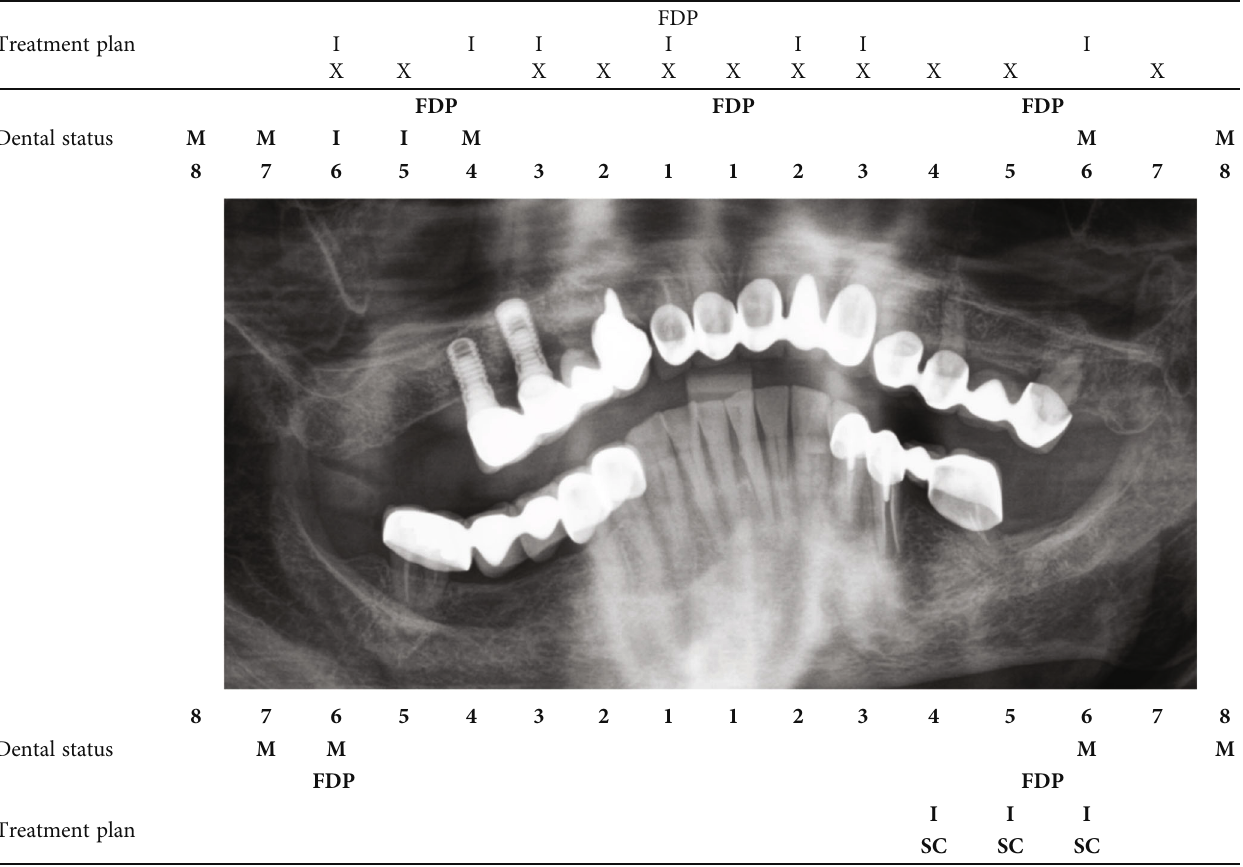
Table 1: DPT, dental status at intake, and treatment planning.